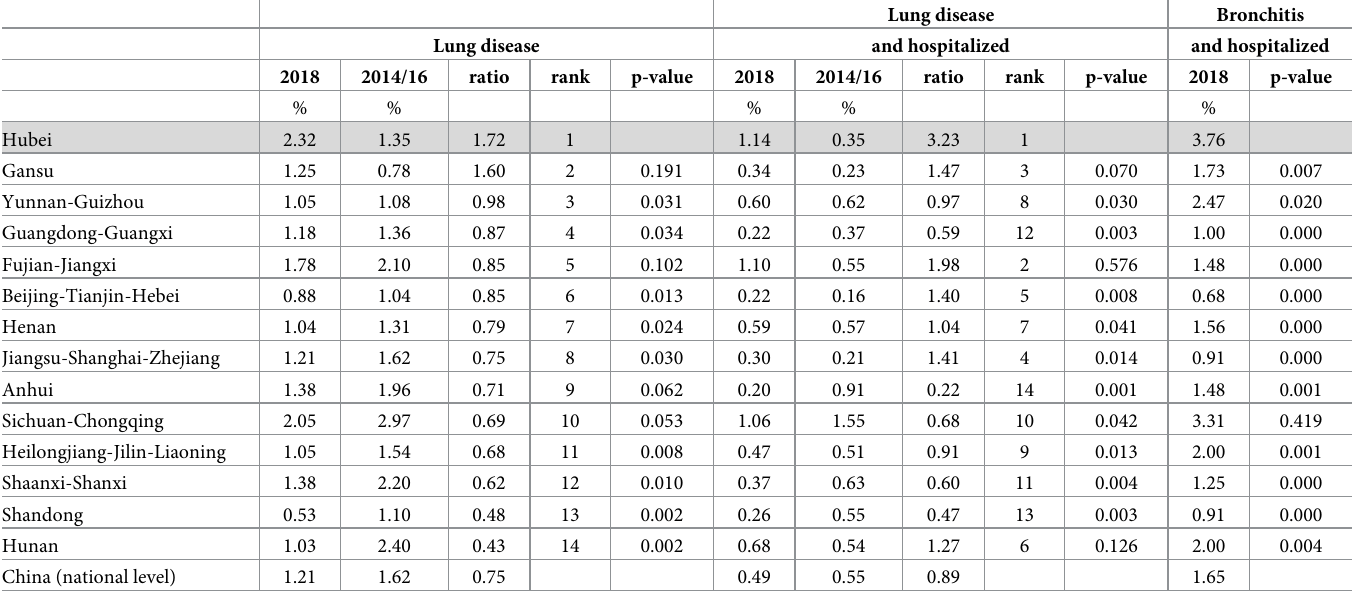
Table 1. Diagnosis of lung disease in past 6 months (CFPS). Lung disease Bronchitis Lung disease and